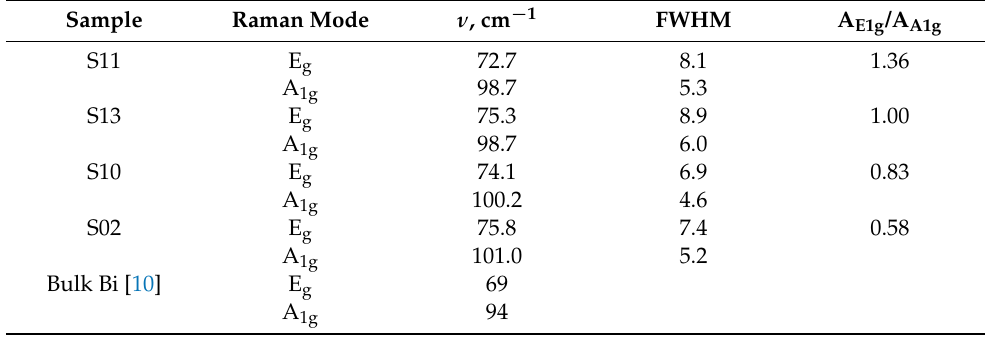
Figure 9. Raman spectra of 9- and 30-nm thick β -Bi ( a ) and α -Bi ( b ). Intensities are normalized to the intensity of the A 1g mode and spectra are shifted vertically for clarity. Table 4. Parameters of Raman bands of Bi thin films grown at different